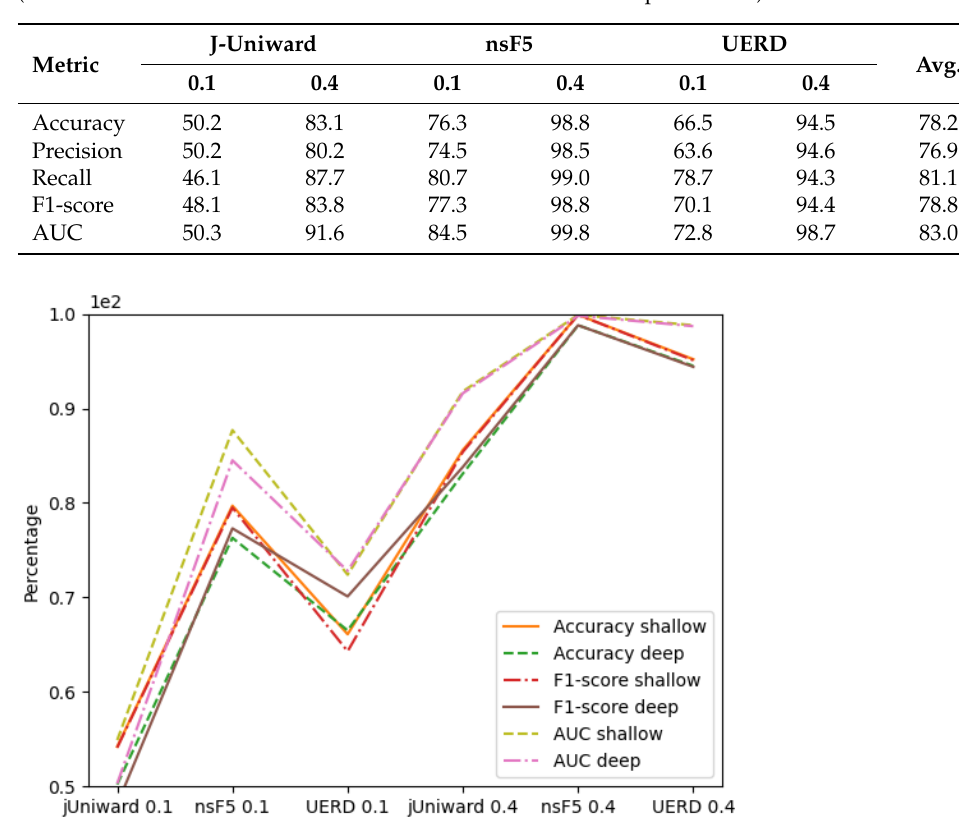
Table 4. Results of image steganography detection (in percentages) for the best deep learning method